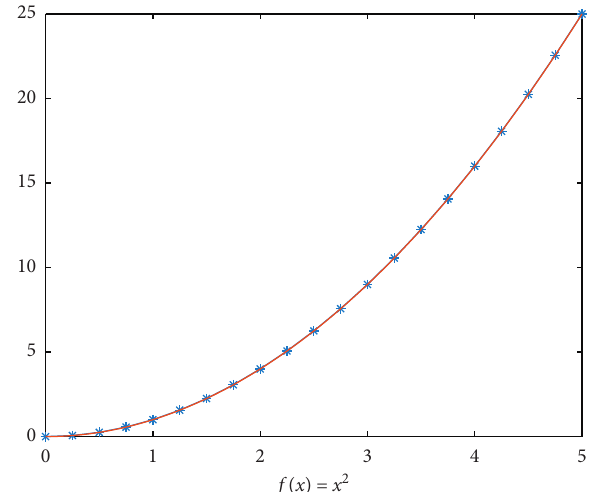
Figure 4: Limit curve by our scheme when lim